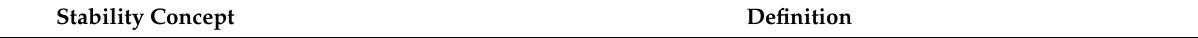
Table 2. Modern stability concepts